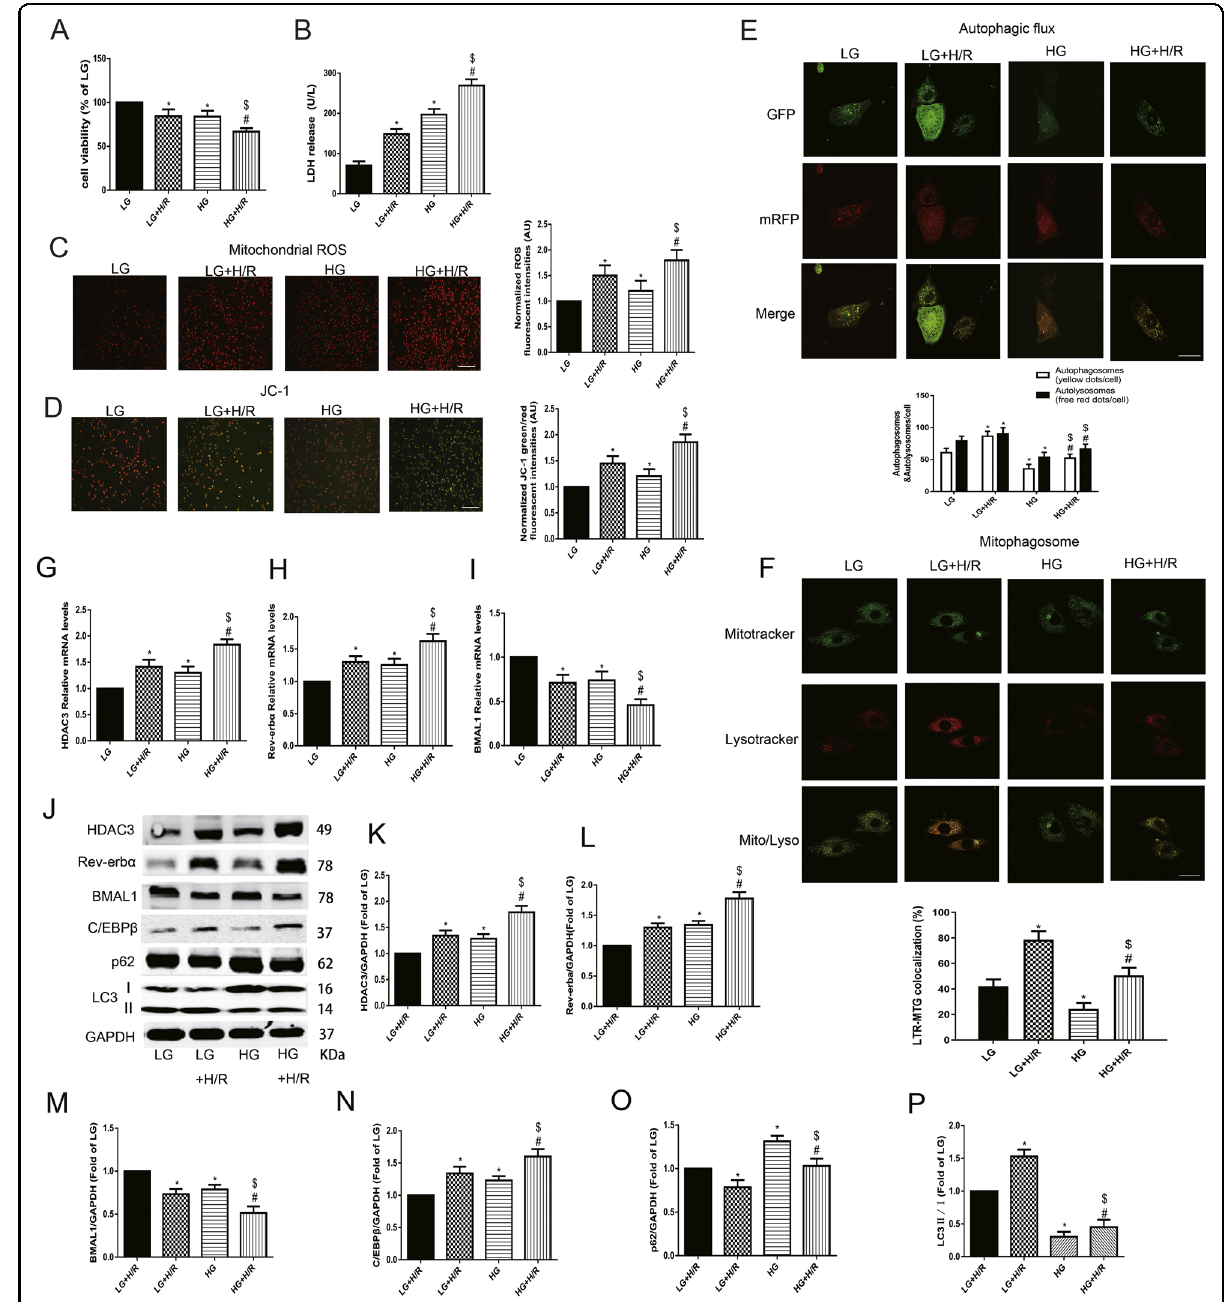
Fig. 5 Upregulated expression of HDAC3 mediated Rev-erb α /BMAL1 in high glucose to increase the vulnerability to H/R by inhibiting mitophagy in neonatal rat cardiomyocytes. A Cell viability was analysed by CCK-8 kit. B Serum level of LDH was detected by ELISA kit. C and D Mitochondrial ROS ( C ) and JC-1 ( D ) were detected to analyse mitochondrial function. Scale bar: 100 μ m. E Tandem fl uorescent mRFP-GFP-LC3 adenovirus was used to detect the autophagic fl ux. Scale bar: 20 μ m. F MitoTracker Green and LysoTracker Red staining were used to detect mitophagosome formation. Scale bar: 20 μ m. G – I The mRNA levels of HDAC3 ( G ), Rev-erb α ( H ) and BMAL1 ( I ) were analysed by qPCR. J – P The protein levels of HDAC3 ( K ), Rev-erb α ( L ), BMAL1 ( M ), C/EBP β ( N ), P62 ( O ) and LC3 II/I ( P ) were analysed by western blotting in the cultured neonatal rat cardiomyocytes. n = 6 per group. * P < 0.05 LG; # P < 0.05 versus HG; $ P < 0.05 versus LG +